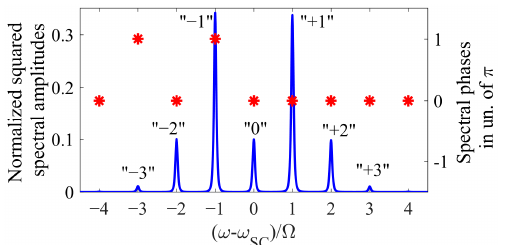
Figure 2. Normalized squared spectral amplitudes (left axis, blue line) and spectral phases at peaks of the squared spectral amplitude (right axis, red stars) (see Equation (9)) of the 14.4 keV Lorentz- squared single ‐ photon wave packet in the vibrating reference frame at p = 1.84, Ω / γ a = 90 ( Ω /(2 π ) ≈ 51 MHz), and ϑ = 0. The “ − 1” spectral line will be removed at the exit from the optically thick absorber. The spectrum normalization is the same as for the red solid curve in Figure 1a.